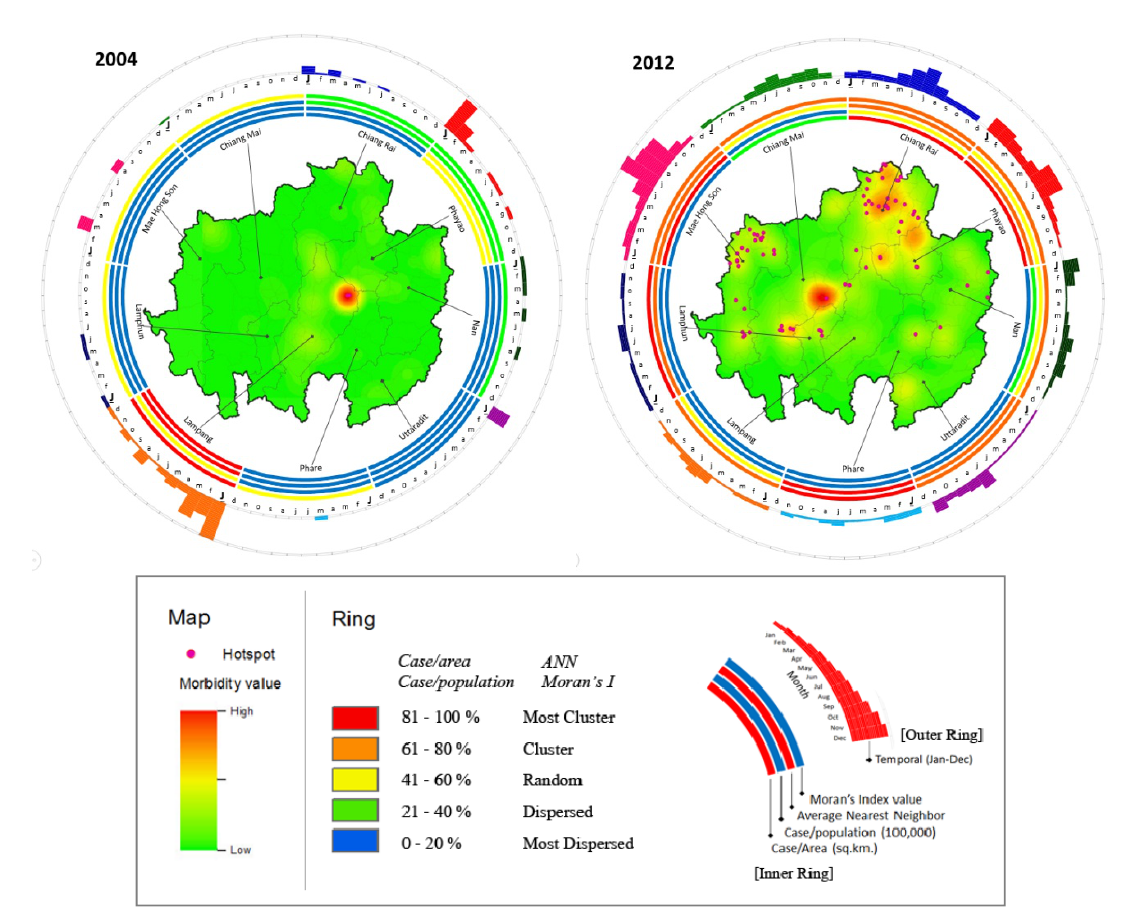
Figure 11. Spatio-temporal ring map: The inner ring shows the spatial distribution of hotspots and morbidity; the outer ring shows the temporal